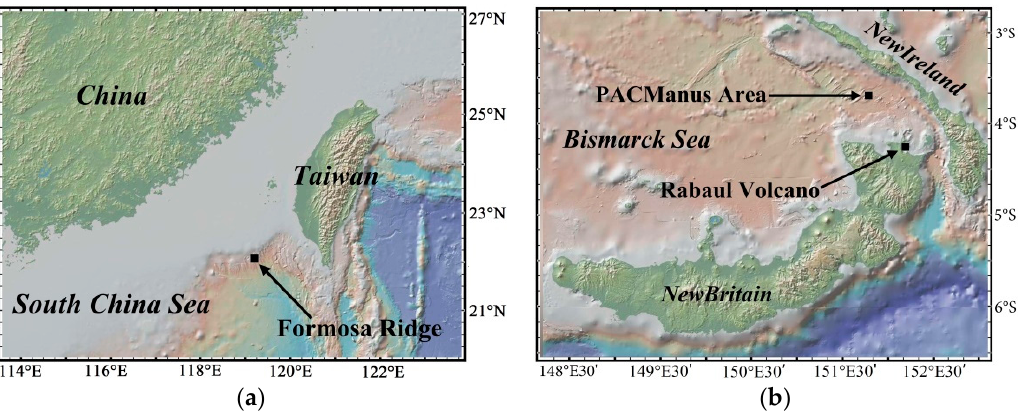
Figure 3. Map location of the sea-going area constructed with GeoMapApp (www.geomapapp.org). ( a ) Cold seep field at Formosa Ridge in the South China Sea [3]. ( b ) PACManus hydrothermal vent area at Paul Ridge in Bismarck Sea [1].